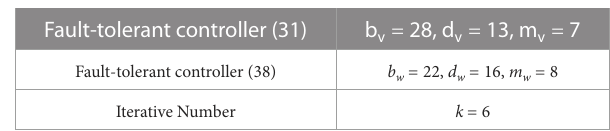
TABLE2 Theconsideredfaults. TABLE3 Parametersofthedesignedfault-tolerantcontroller.